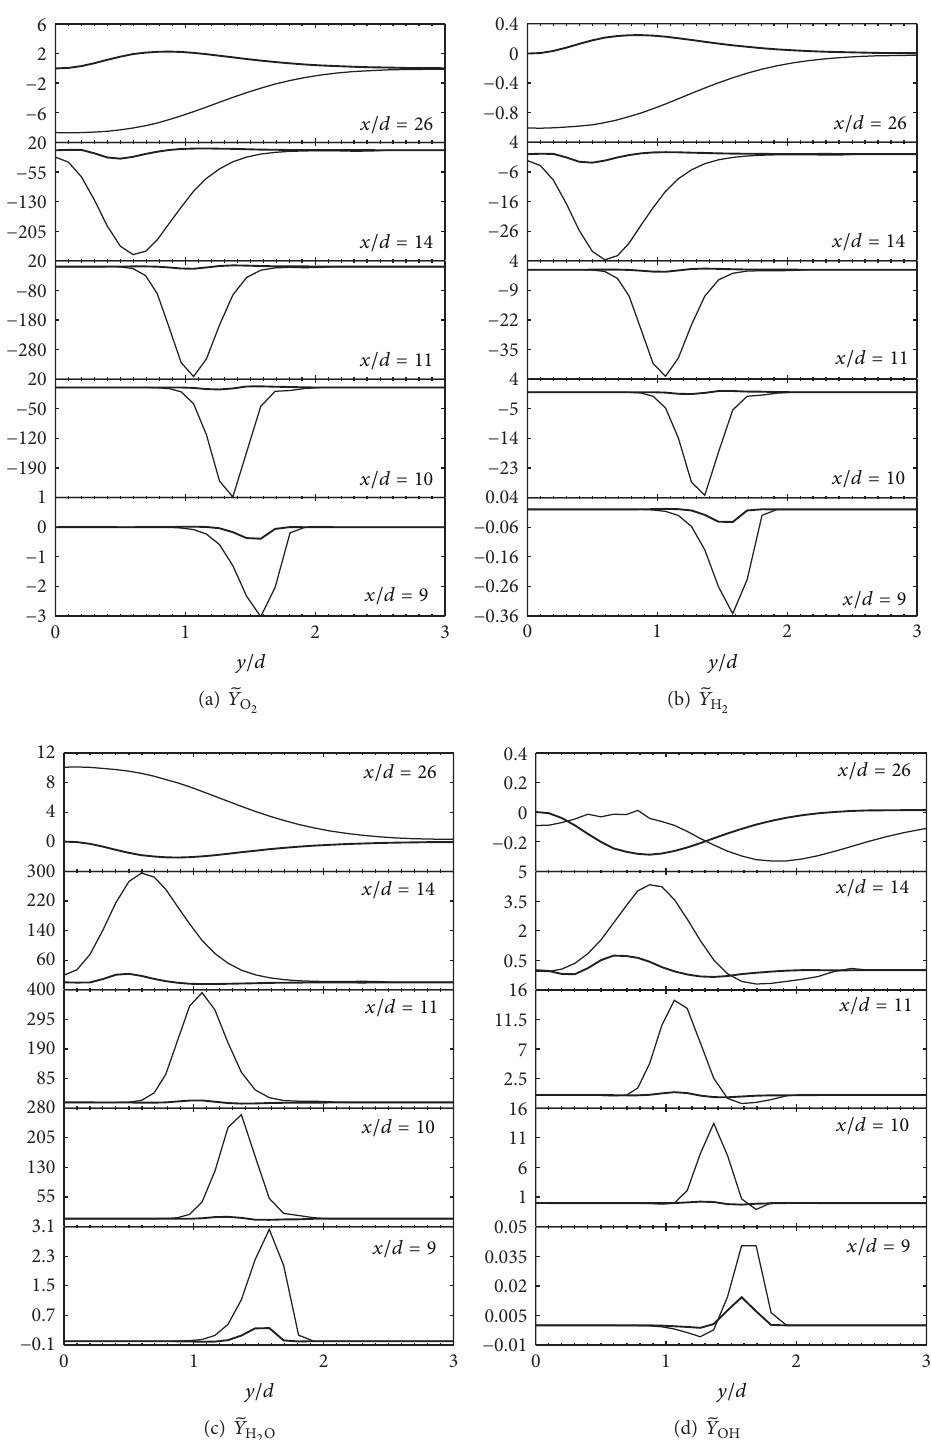
Figure 10: Radial profiles of the chemical and spurious sources obtained in the PMF-PDF case for 𝑇 𝑐 = 1045 K: (a) O (d) OH. Thin lines, chemical sources; thick lines, spurious sources. The units are s − 1